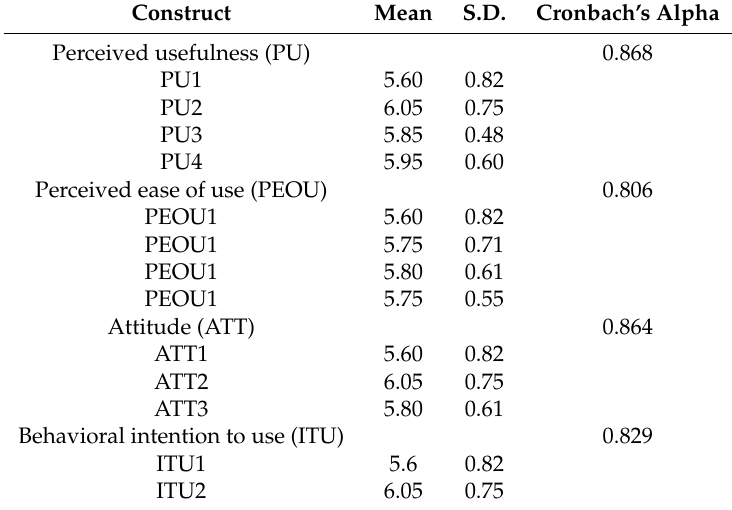
Table 6. Analysis of measurement reliability: descriptive statistics and Cronbach’s